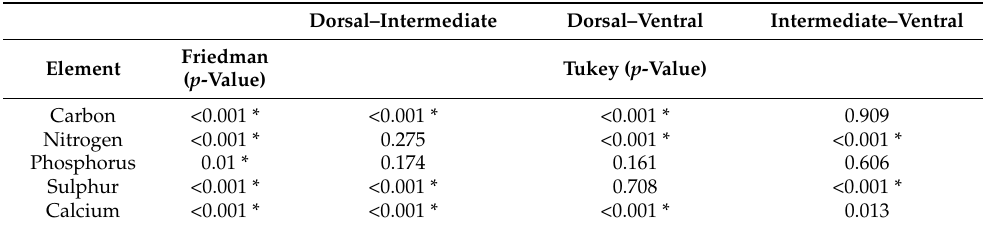
Table 5. Comparison of WT% values of elements by layer. *, significant difference.